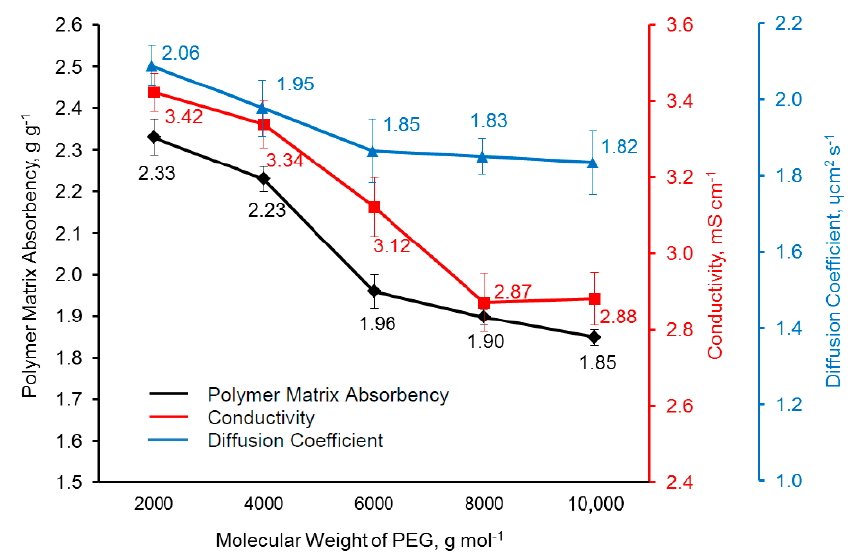
Figure 7. Polymer matrix absorbency, conductivity, and diffusion coefficient of PU matrices of different PEG molecular weights.